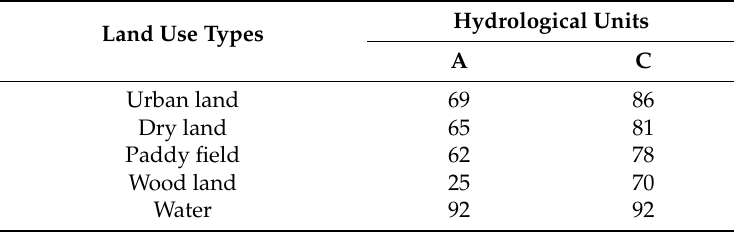
Table 3. Curve Number (CN) values of combination of different hydrological units and land use types in the study